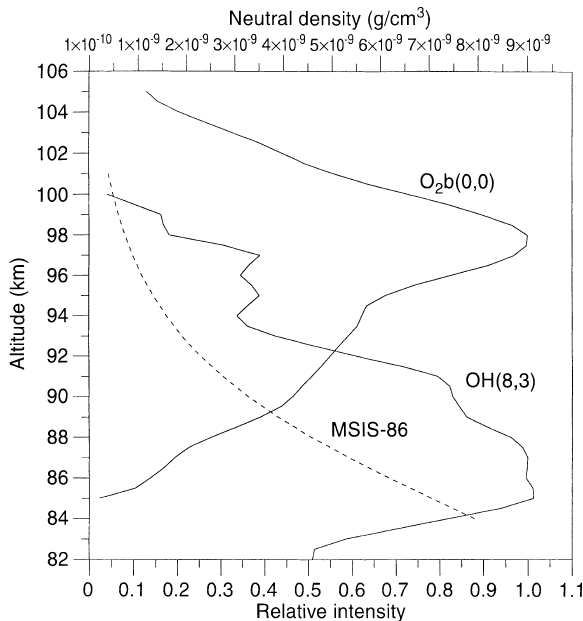
Fig. 1. The OH (cid:133) 8 ; 3 (cid:134) and O 2 b (cid:133) 0 ; 0 (cid:134) volume emission profiles obtained from the rocket-borne measurements at Alcaˆ ntara (cid:133) 2 (cid:14) S ; 44 (cid:14) W (cid:134) (Melo, 1994) and neutral density profile from the MSIS-86 for June at midnight at (cid:133) 23 (cid:14) S ; 45 (cid:14) W